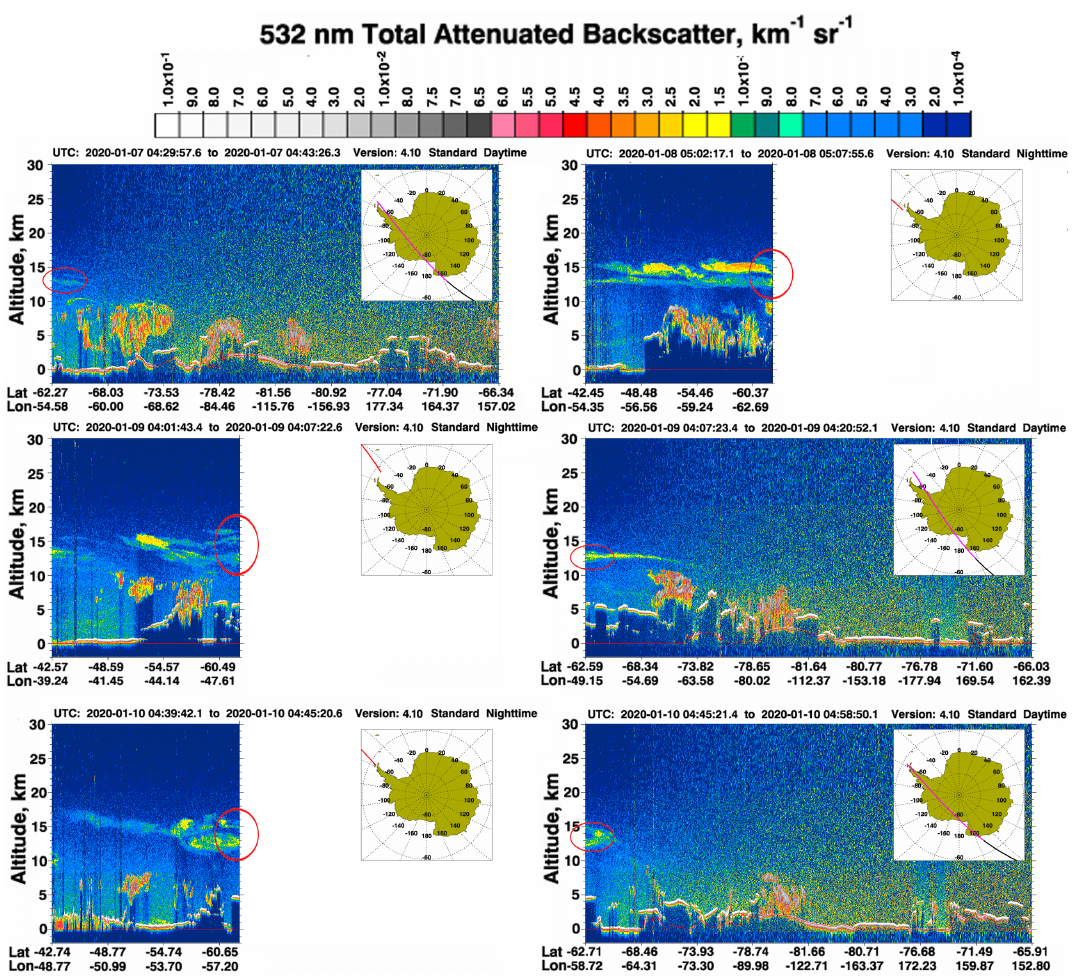
Figure 3. Vertical profiles of total attenuated backscatter at 532 nm from CALIOP/CALIPSO overpasses. The profiles are shown for six different overpasses from 7th to 10th January 2020. The highest aerosol layers close to Marambio location are marked with a red